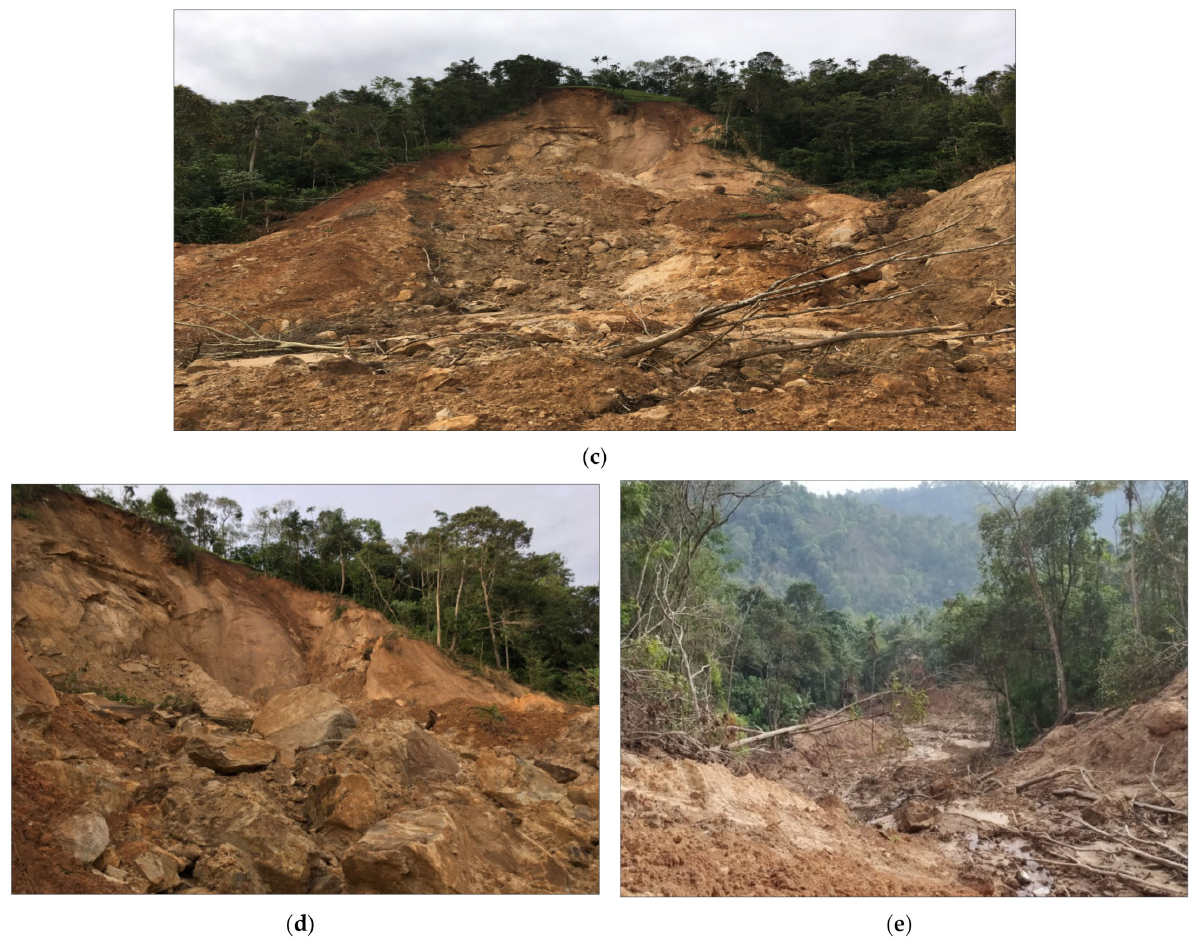
Figure 4. View of landslide in study area. ( a ) Overall view of the landslide, ( b ) run-out portion of the slide, ( c ) crown portion of the slide, ( d ) slip surface of the slide, ( e ) deposition area of the slide.